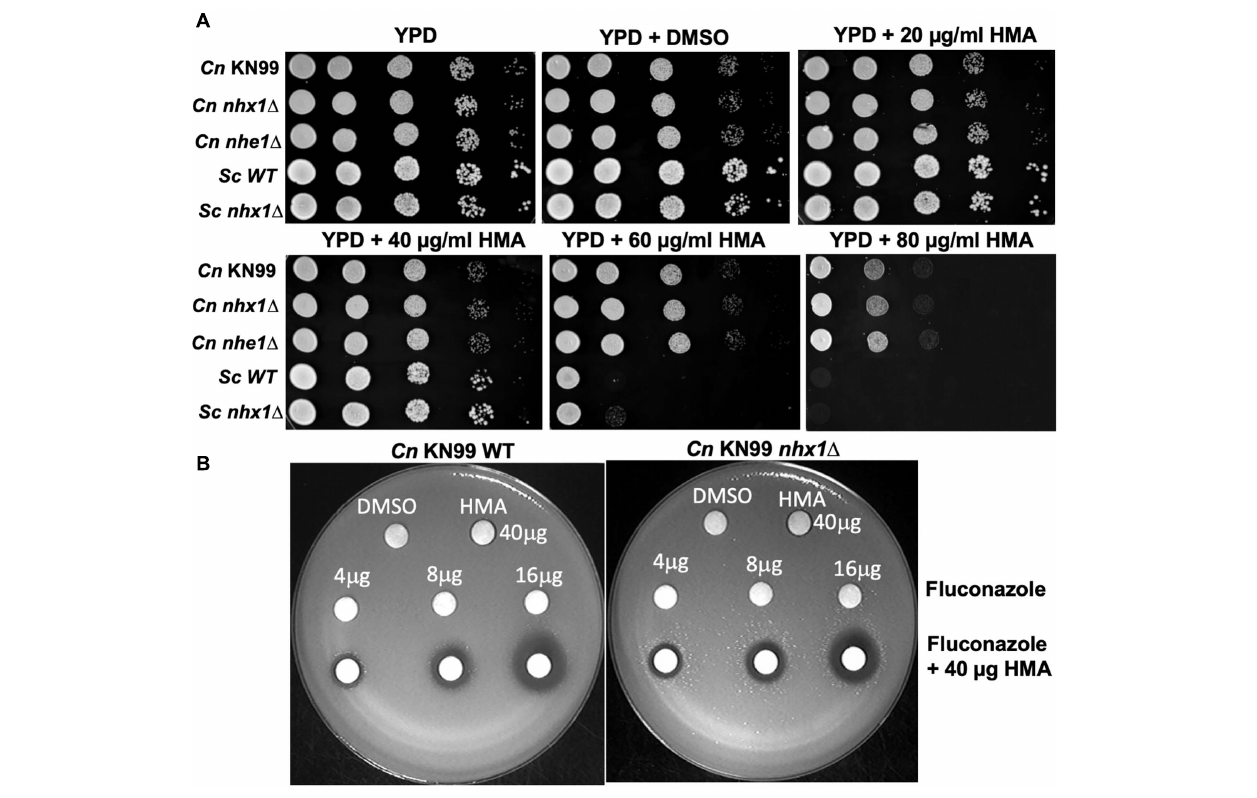
FIGURE 4 | Fungal/yeast cells lacking Na + /H + exchangers, Nhx1 or Nhe1, are sensitive to HMA. (A,B) Growth sensitivity assays of the C. neoformans KN99 wild type strain, nhx1 (cid:49) and nhe1 (cid:49) strains demonstrate a similar dose-dependent response to HMA. The background strain of nhx1 (cid:49) and nhe1 (cid:49) is KN99. Sc – Saccharomyces cerevisiae W303 a strain. Background strain of Sc nhx1 (cid:49) is W303 a. (B) Disk diffusion assay shows a similar response of KN99 wild type and nhx1 (cid:49) strains to HMA with or without fluconazole. A lawn of KN99 wild type and nhx1 (cid:49) strains were tested with either HMA (40 µ g), fluconazole (4–16 µ g) or fluconazole (4–16 µ g) in combination with HMA (40 µ g HMA). Images shown are representative of at least three